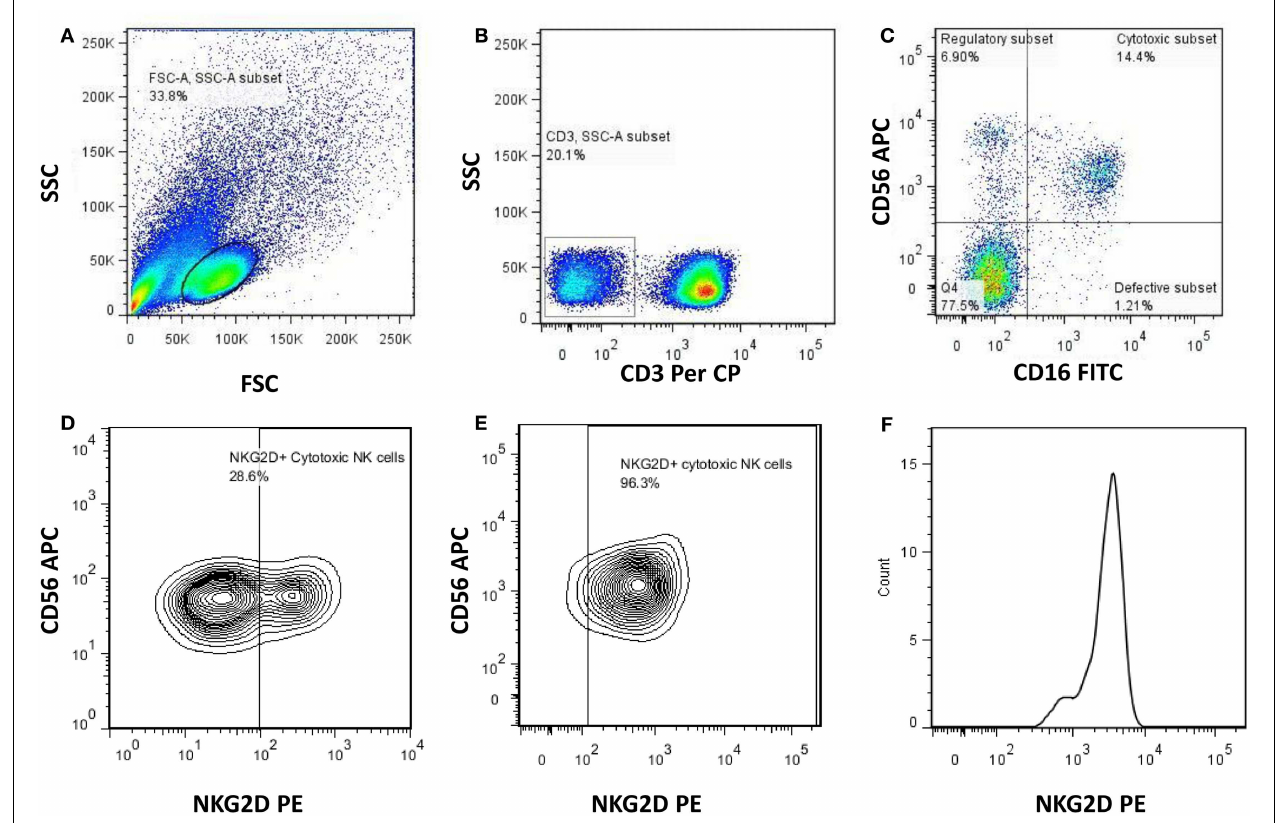
FIGURE 1 | Gating strategy used to identify NK cells and the NK cell subsets . Representative flowcytometry plots from the PBMCs of one of the study participants.The lymphocytes were live gated during acquisition using the side and forward scatter dot plot display (A) . Furthermore, by using the negative gating strategy, CD3-negative lymphocyte population was identified (B) .The NK cell population was further identified and differentiated into regulatory (CD3 − CD16 − CD56 + ),